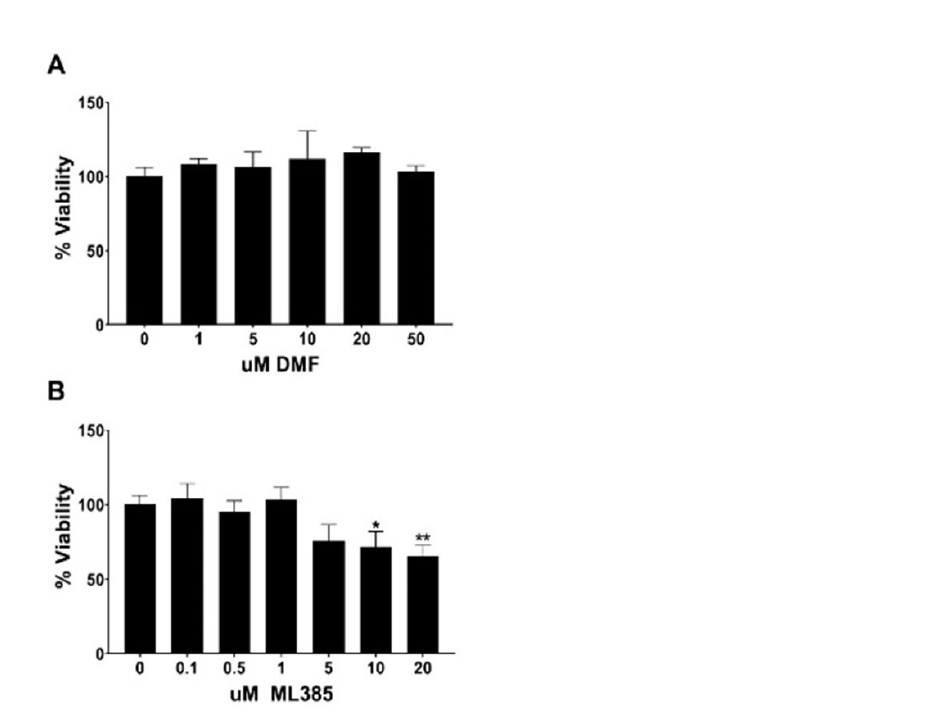
Figure 1. Cytotoxicity of DMF and ML385. ( A ) No cell death was observed at any of the concentrations of DMF tested whereas ( B ) significant cytotoxicity was seen when cells were treated with concentrations of ML385 of 10 µ M or higher. Significance is relative to control ( * p < 0.05, ** p < 0.01).